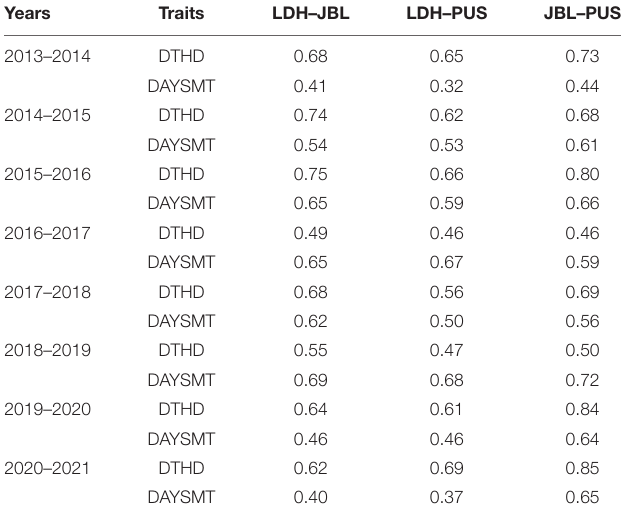
TABLE 2 | Phenotypic correlations between locations for days to heading (DH) and days to maturity (DM) from 2014 to 2021. Years Traits